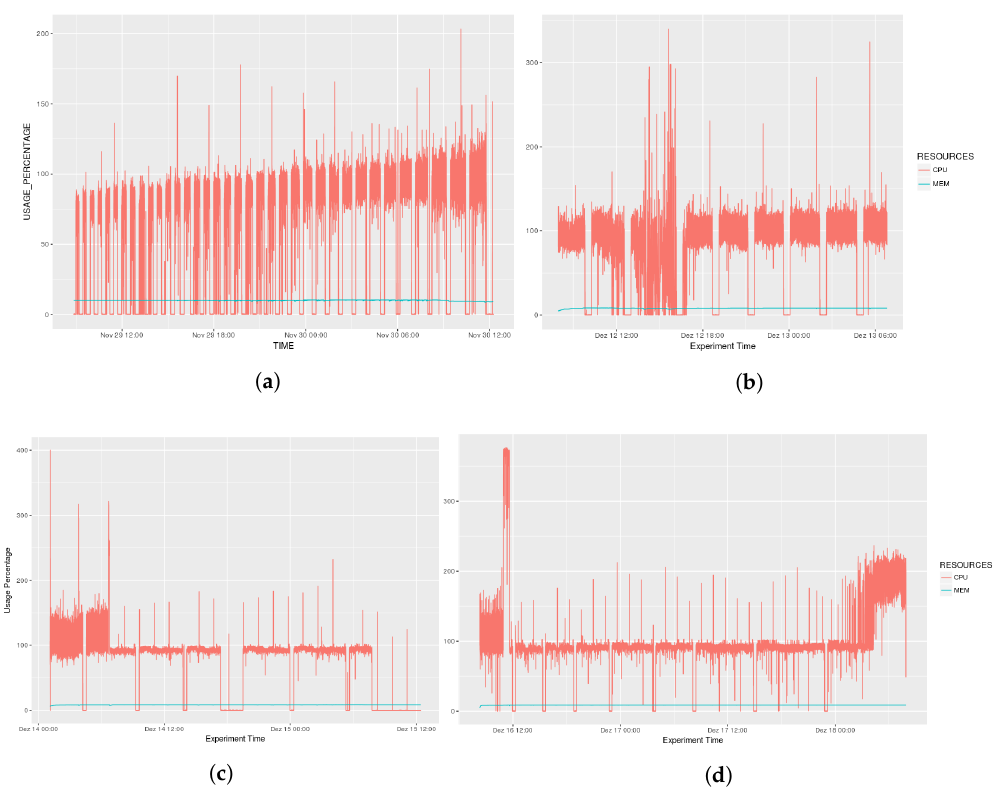
Figure 13. Resource Management. ( a ) Scenario 01; ( b ) Scenario 02; ( c ) Scenario 03; ( d ) Scenario